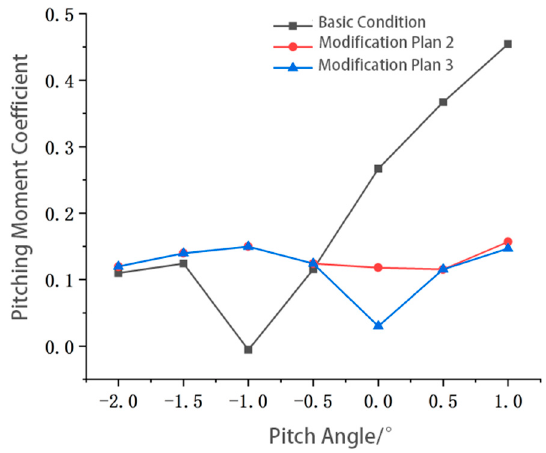
Figure 24. Comparison curve of pitching moment coefficient